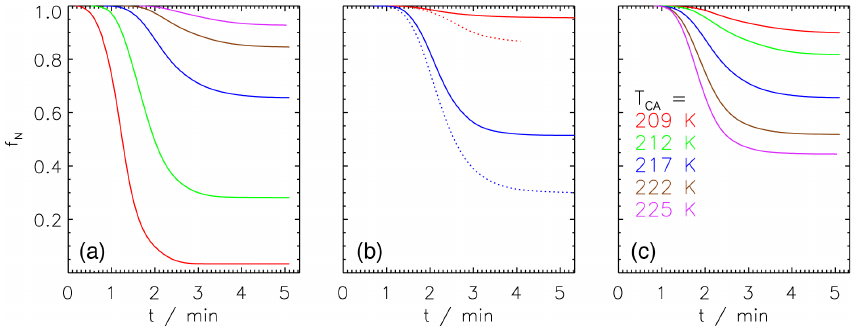
Figure 3. Temporal evolution of normalised ice crystal number is shown. Panels (a) and (b) show the same simulations as Fig. 2, except that in panel (b) RH i = 120% instead of 140%. Panel (c) shows the effect of a temperature variation (see legend) at RH i = 120% and N BV = 0 . 0115s − 1